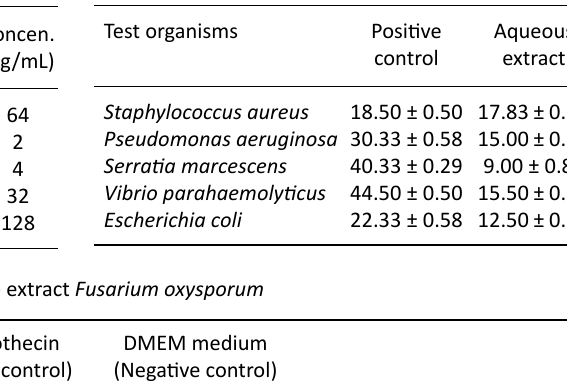
table 2. Inhibition zone diameter of water extracts to organisms